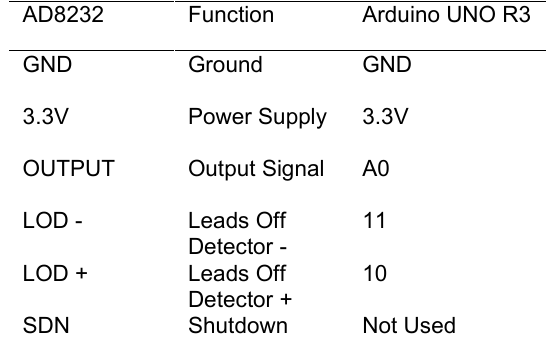
Table 1. Pin connections of AD8232 with Arduino